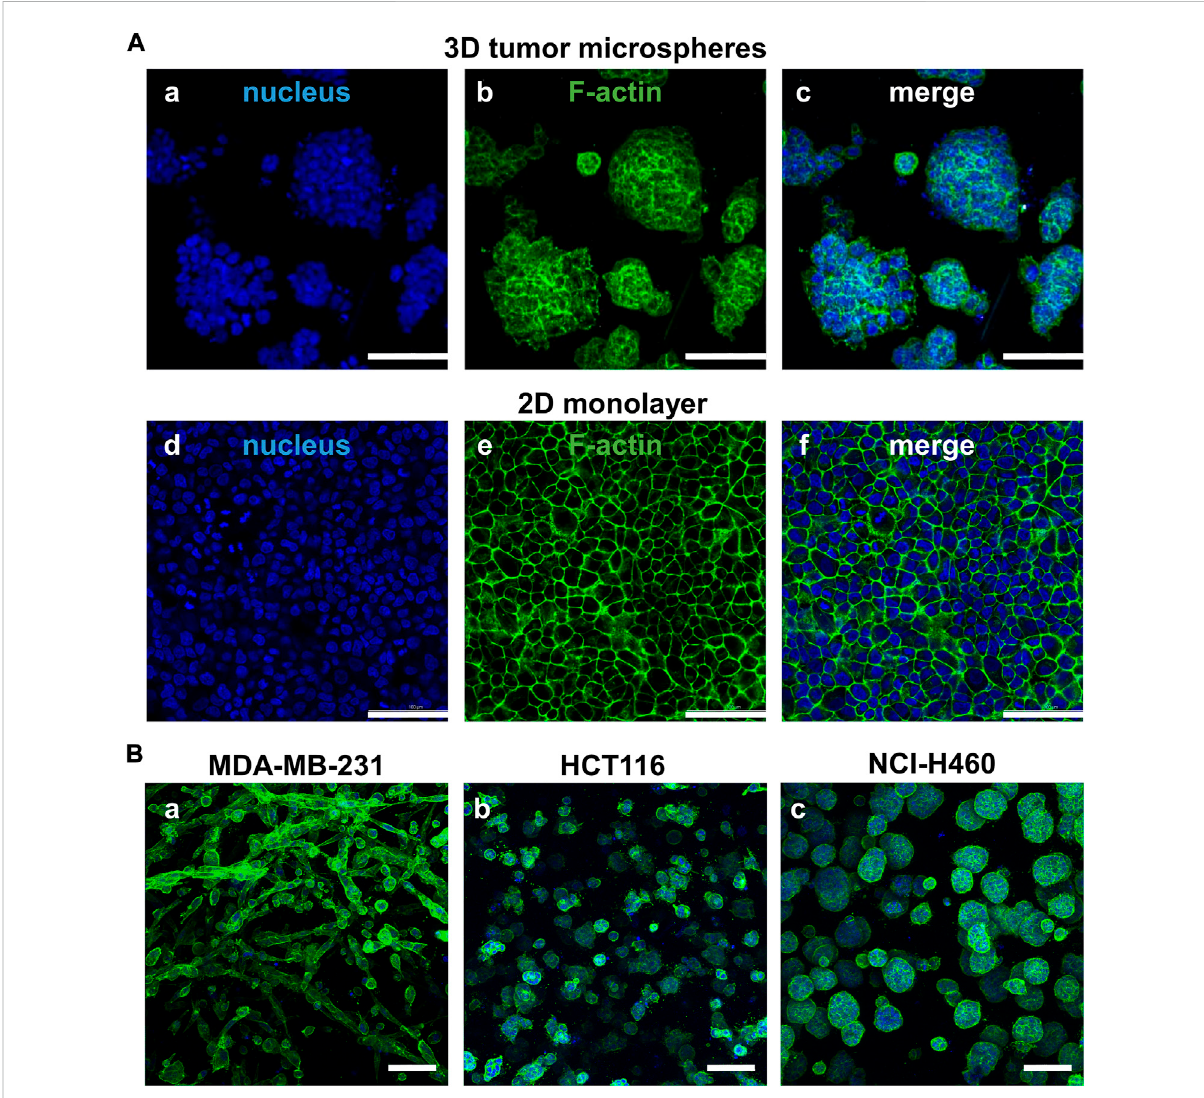
FIGURE 2 Comparison of cell morphology between the paired 2D models and 3D models. (A) Different cell morphology of NCI-H460 cells cultured on the 2D and 3D models staining by F-actin (green) and nuclei (blue). (B) The cell morphology of three representative cell lines cultured on the 3D tumor model. Scale bar = 100